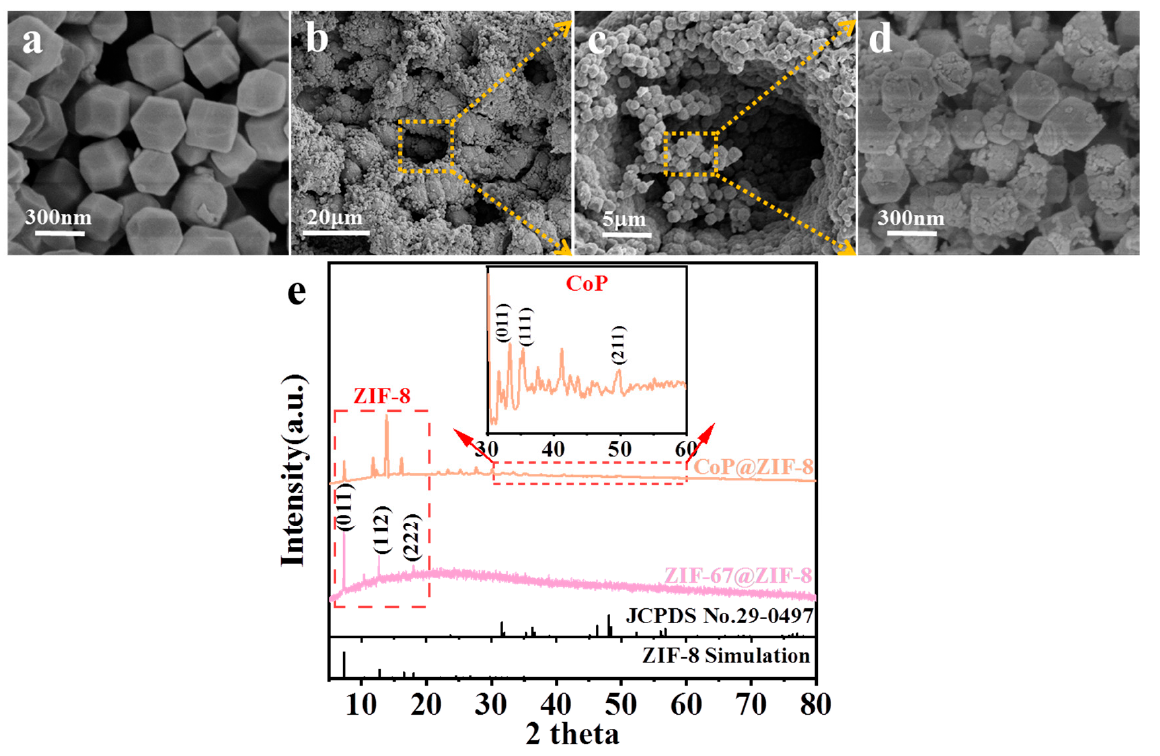
Figure 5. SEM images of the ZIF-67@ZIF-8 ( a ) and CoP@ZIF-8/pNF ( b – d ); XRD patterns ( e ) of the ZIF-67@ZIF-8 and CoP@ZIF-8.